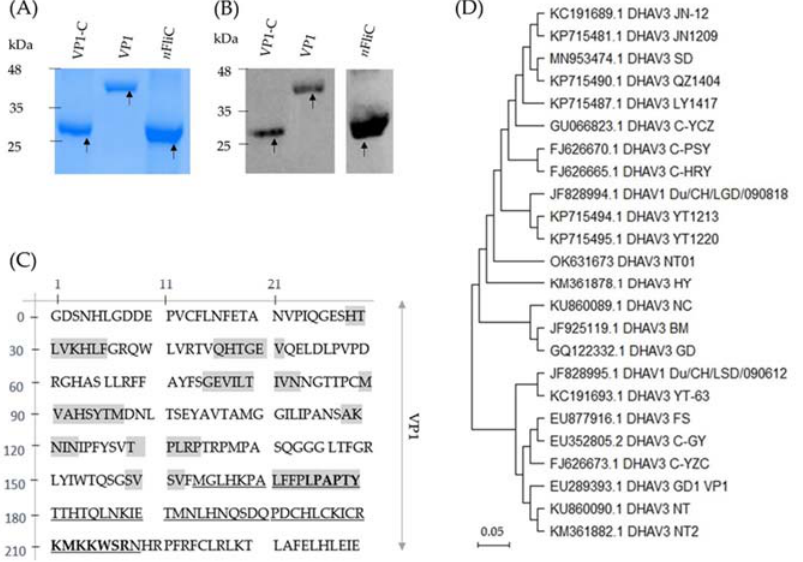
Figure 1. Recombinant protein expression of VP1, VP1-C, and n FliC. ( A ) SDS-PAGE and ( B ) Western blot analysis were performed for the purified recombinant proteins. ( C ) Protein sequence of cloned VP1 from the DHAV-3 strain NT01 used in this study is shown. Predicted β -strands (highlighted in grey), potential conserved B cell epitope, heparan-binding site (bold font), and VP1-C (underlined) are indicated. Prediction of β -strand locations is based on sequence comparison with the VP1 gene of the Human Parechovirus 1 strain, Harris (protein data bank ID: 5MJV). ( D ) Phylogenetic analysis of NT01 VP1 amino acid was performed with 23 DHAV isolates of two serotypes (DHAV1 and DHAV3). Phylogenetic analysis was performed using the maximum likelihood method (in the MEGA 11